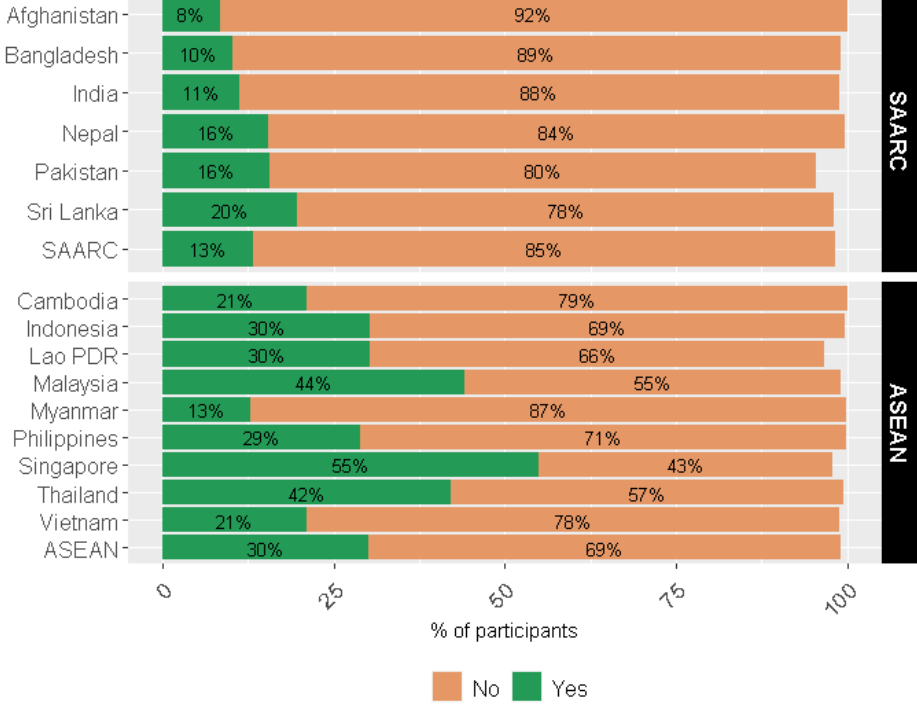
Figure 7. Percentage of participants who saved money for old age.